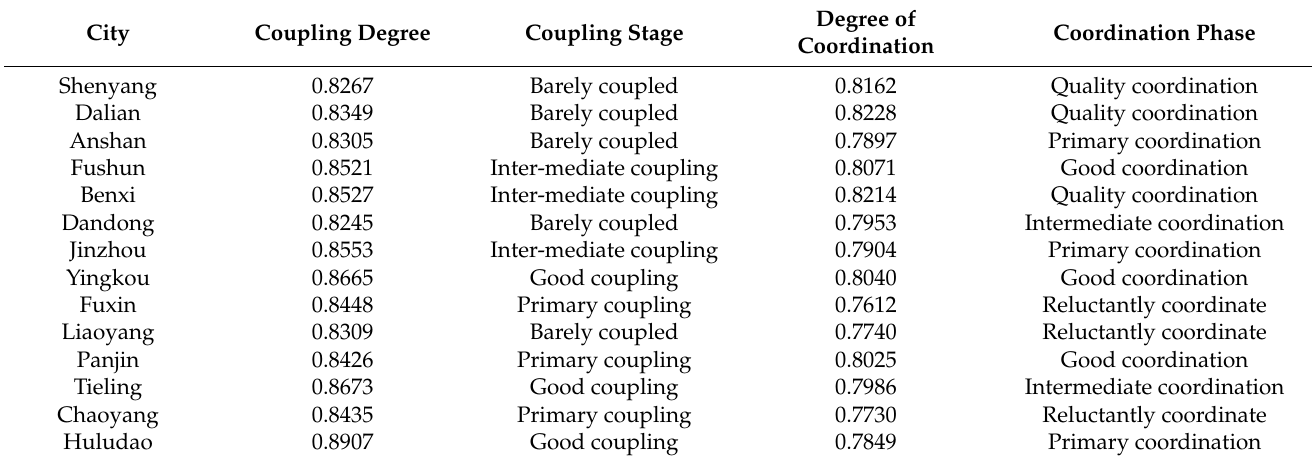
Table 5. Coupling coordination degree of LCCC system in Liaoning